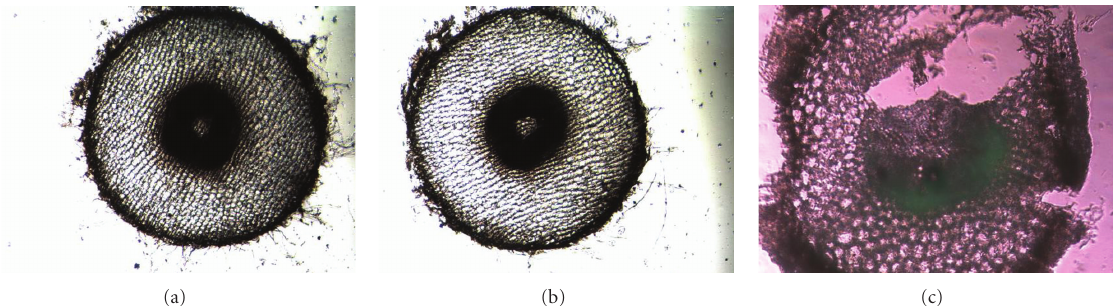
Figure 5: Transverse section of gram-seedling roots (a) control, (b) at 1ppm, and (c) at 2000 ppm of nano-ZnO treatment.